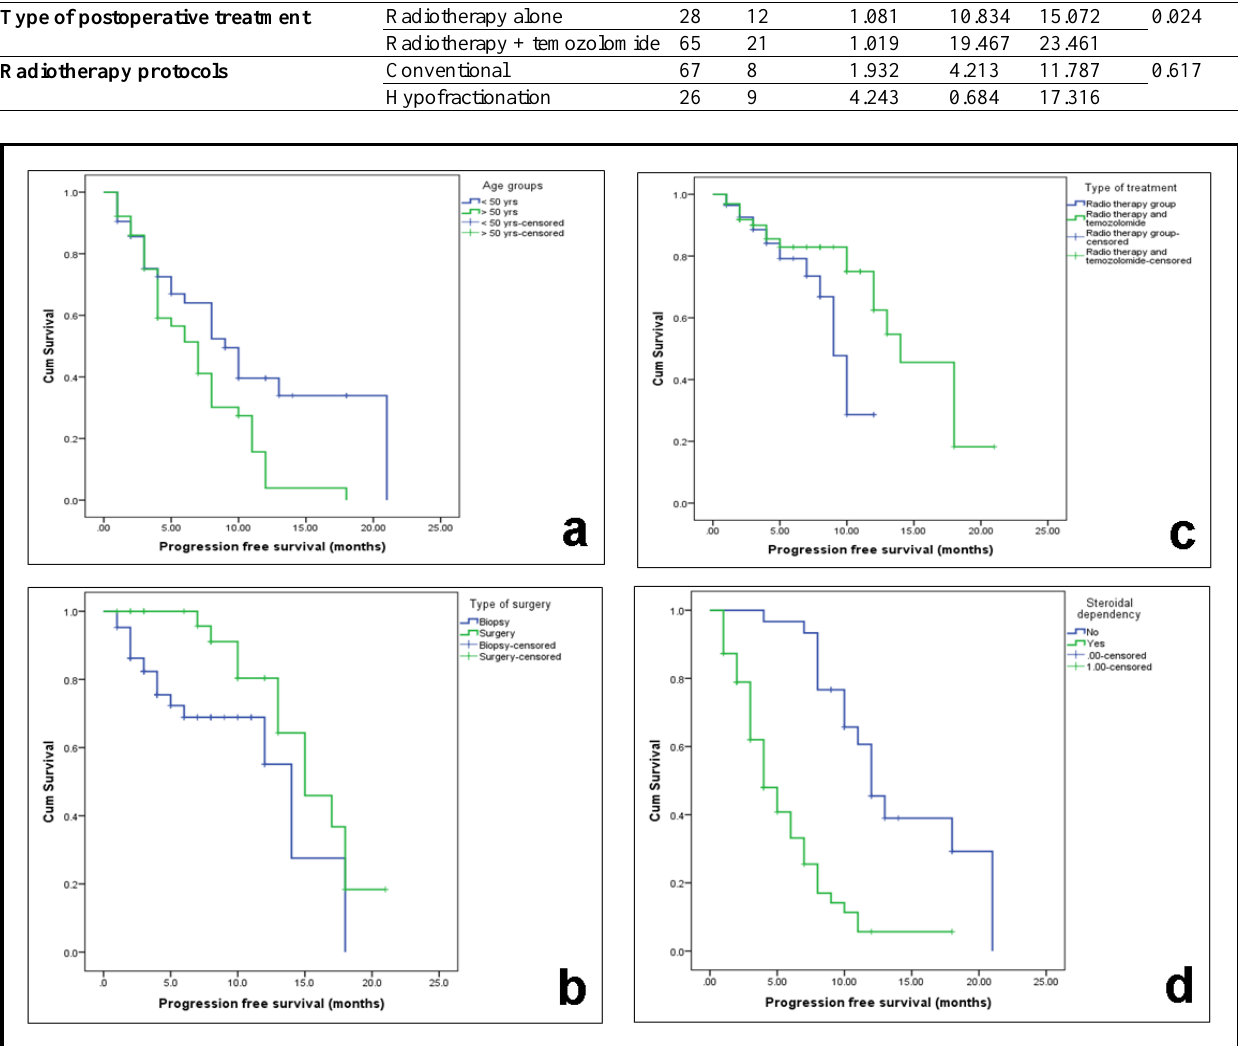
Figure 3: Kaplan-Meier progression free survival curves according to: a) age, b) type of surgery, c) type of post- operative treatment and d) steroidal